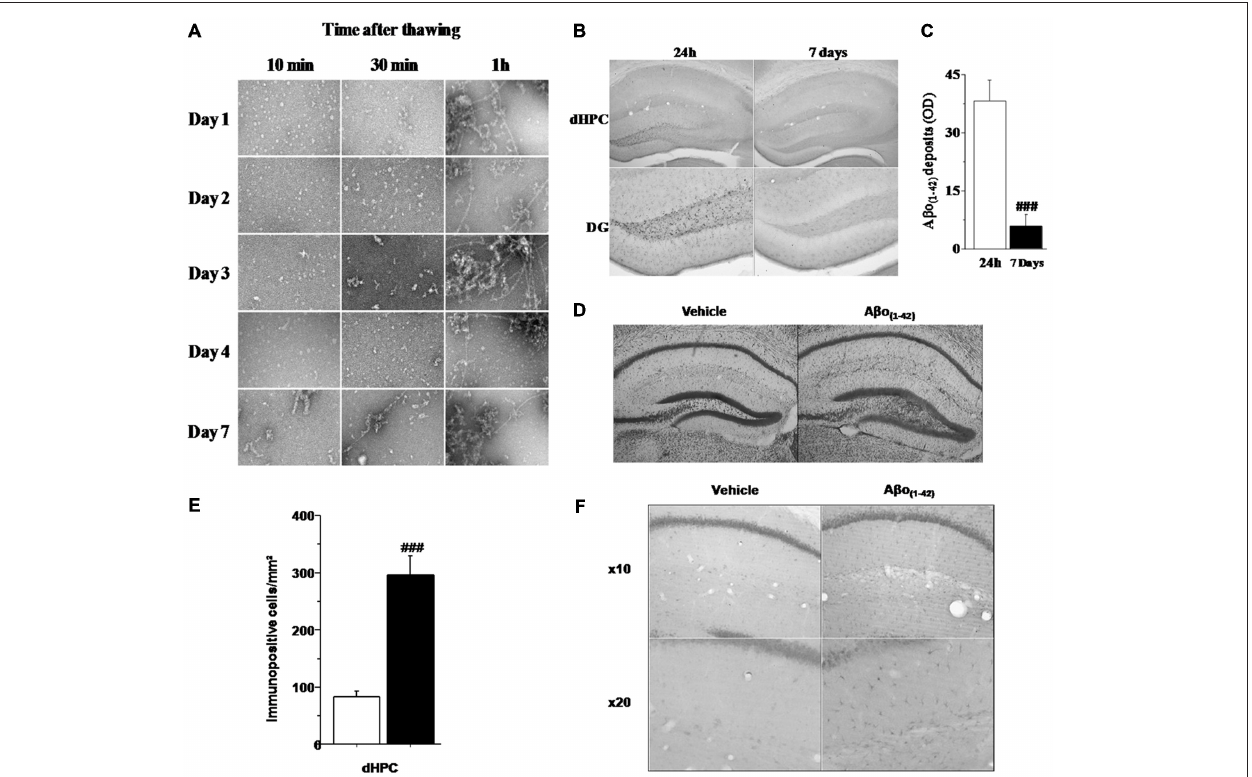
FIGURE 2 | Histological characteristics of the in vivo model based on four consecutive injections of A β o ( 1 – 42 ) . (A) Transmission electron microscopy (TEM) analysis of A β ( 1–42 ) purified solution injected in vivo into the dCA1. The analysis was performed every day during 7 consecutive days at 10, 30 and 1 h after thawing. The results showed that from day 1 to day 4, the solution was mainly composed of oligomeric A β o ( 1–42 ) assemblies when thawing did not exceed 30 min. (B) Semi-quantitative analysis of A β o ( 1–42 ) deposits (expressed as mean optical density (OD) in the dHPC) region of mice sacrificed 24 h or 7 days after the last injection ( n = 5 for each group). (C) Low magnification photomicrographs of A β o ( 1–42 ) deposits within the entire dHPC (top) and higher magnification photomicrographs of the dentate gyrus (DG; bottom) from A β o ( 1–42 ) -injected mice sacrificed 24 h or 7 days after the last injection. (D) Representative dHPC sections 7 days after the last intradCA1 injections of A β o ( 1–42 ) or vehicle solution stained by thionine. A β o ( 1–42 ) intra-dCA1 injections induce neuronal death specifically in the DG. Effect of intra-hippocampal injections of A β o ( 1–42 ) on GFAP expression in the dorsal hippocampus. (E) Comparison between A β o ( 1–42 ) -injected mice ( n = 8) and Vehicle-injected mice ( n = 8). A β o ( 1–42 ) injections into the dCA1 induce an increase of GFAP expression specifically in the dHPC. (F) Low magnification photomicrographs of GFAP immunopositive cells in the dHPC of Vehicle-injected and A β o ( 1–42 ) -injected mice showing an increase of GFAP immunoreactivity in mice receiving intra-dCA1 injections of A β o ( 1–42 ) . # : Between-group comparisons: ### p < 0.001